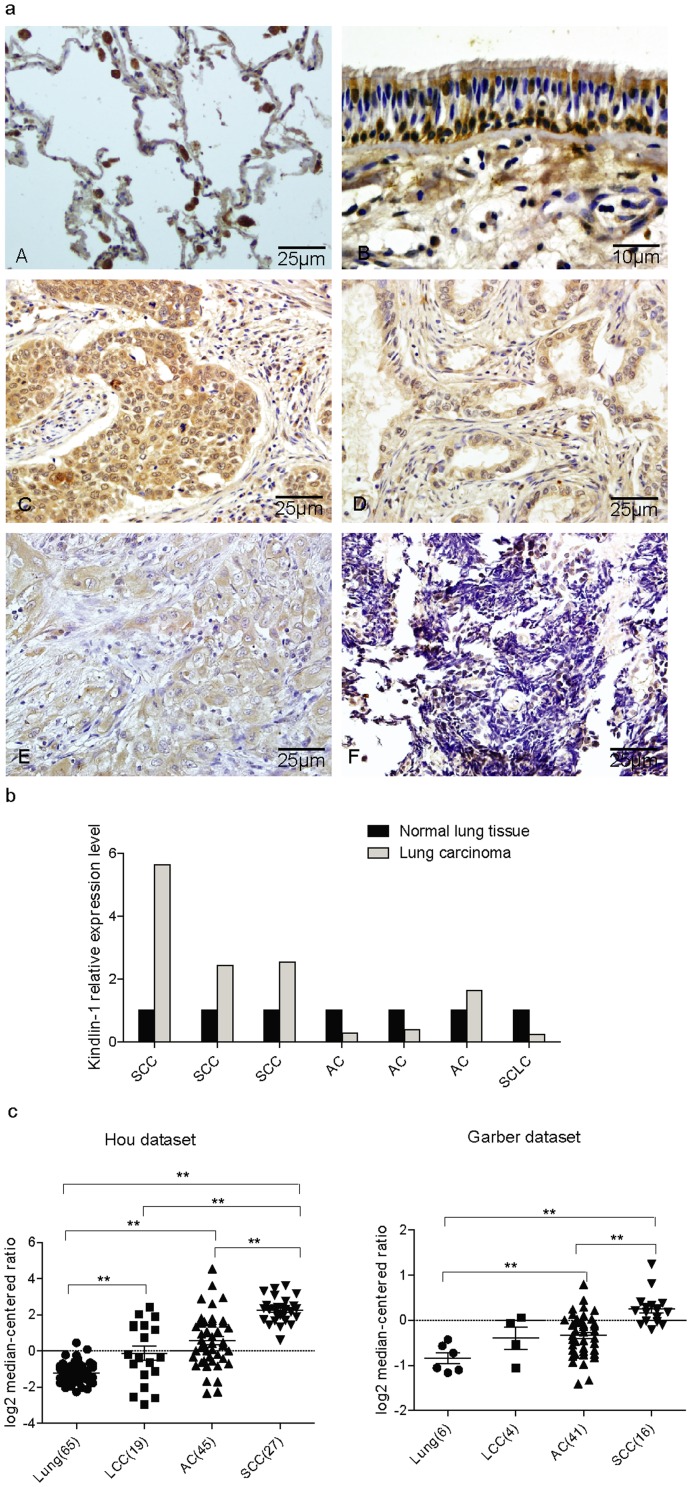
The expression pattern of Kindlin-1 in different subtypes of lung cancer.a. Kindlin-1 expression in tissues from normal and different subtypes of lung cancer examined by IHC. Photos displayed are normal lung (A), Pseudo-stratified ciliated columnar epithelium (B), SCC (C), AC (D), LCC (E), and SCLC (F). b. Determination of the mRNA levels of Kindlin-1 in the fresh clinical specimens measured by qPCR. c. Re-analyses of Kindlin-1 expression in Oncomine database. Left: Kindlin-1 expression extracted in Hou lung dataset; Right: Kindlin-1 expression extracted in Garber lung dataset. Statistical analyses between different patient groups were examined by Student's t test. ** represents for p<0.01.